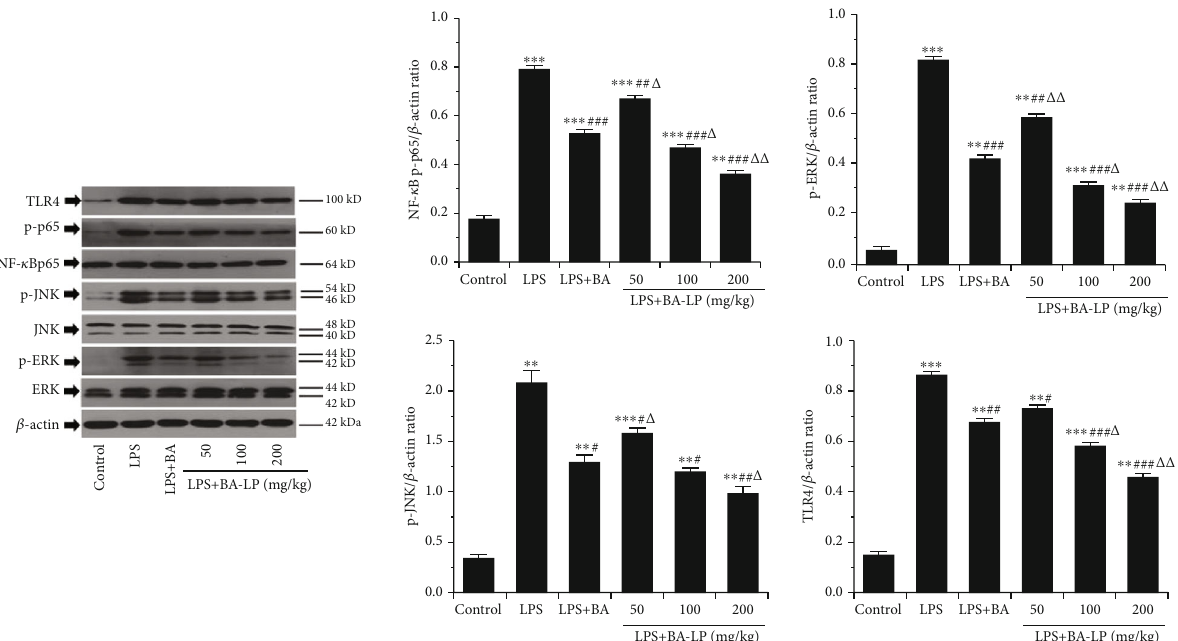
Figure 6: E ff ects of BA on the TLR4/JNK/ERK/NF- κ B signaling pathway. The expressions of TLR4 protein; phosphorylation of NF- κ Bp65, JNK, and ERK; and total NF- κ Bp65, JNK, and ERK in lung tissues of mice were determined by western blotting. β -Actin was used as an internal control. The values were presented as means ± SD ( n = 3 ). ∗ P < 0 : 05 , ∗∗ P < 0 : 01 , and ∗∗∗ P < 0 : 001 vs. the control group; # P < 0 : 05 , ## P < 0 : 01 , and ### P < 0 : 001 vs. the LPS group; and △ P < 0 : 05 and △△ P < 0 : 01 vs. the LPS+BA